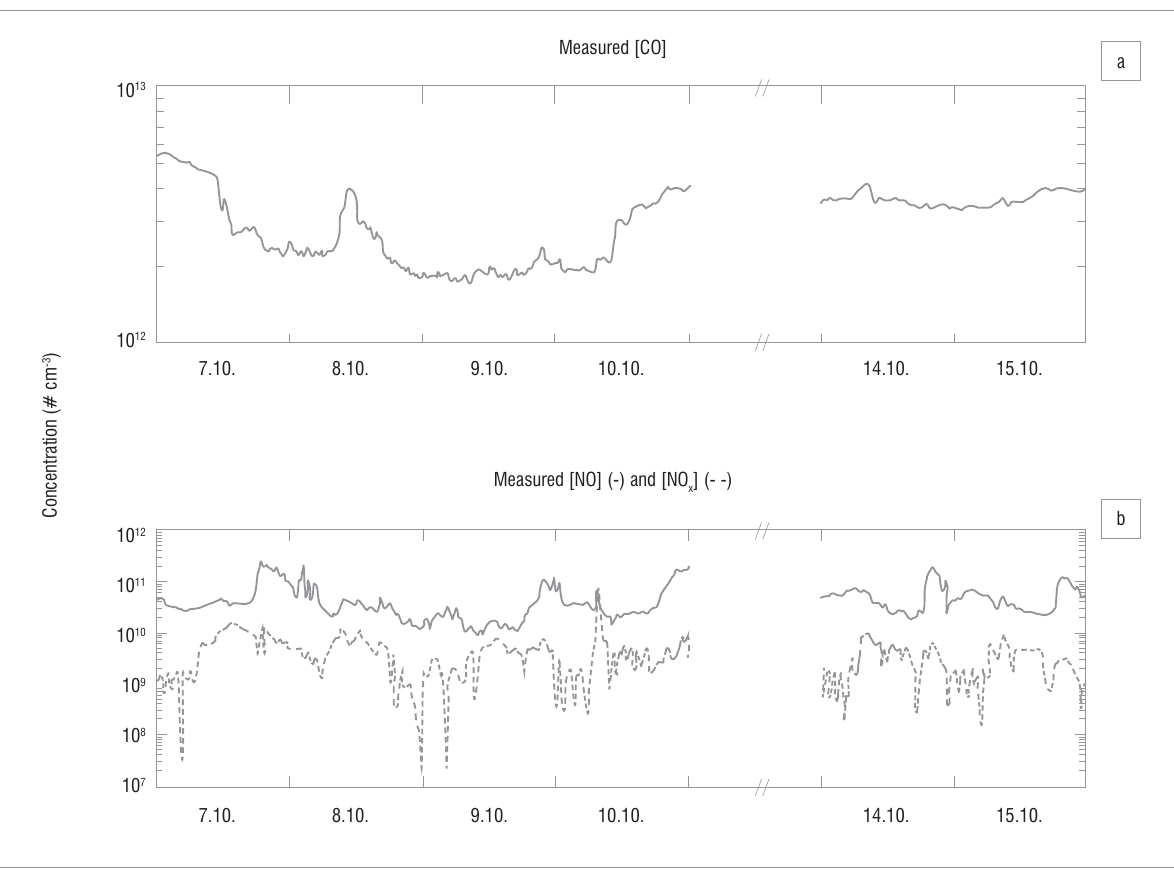
Figure 4: Measured (a) CO, (b) NO (–) and NO